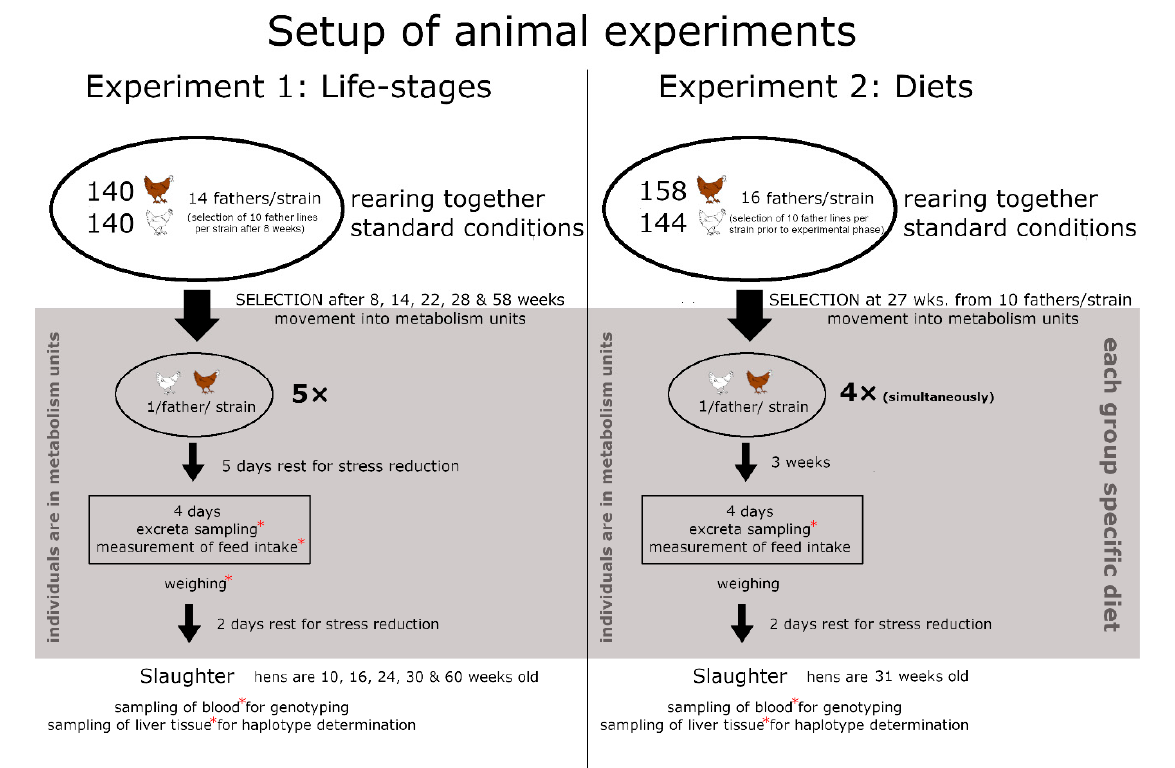
Figure 1. Schematic description of the setup of both animal experiments. Red asterisks mark material and measurements that were used in this study.